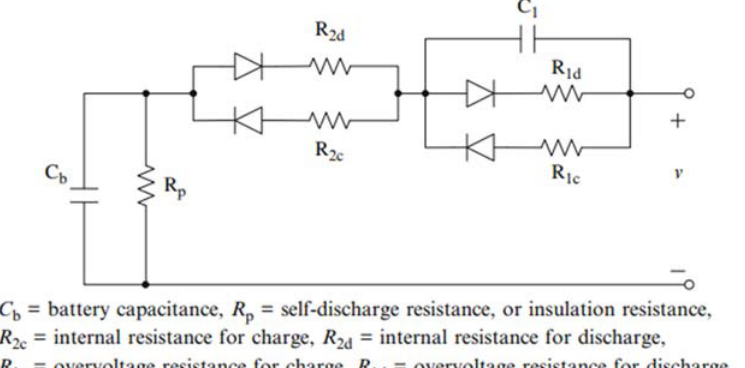
Figure 4. Equivalent circuit model of a battery. Taken from [55].